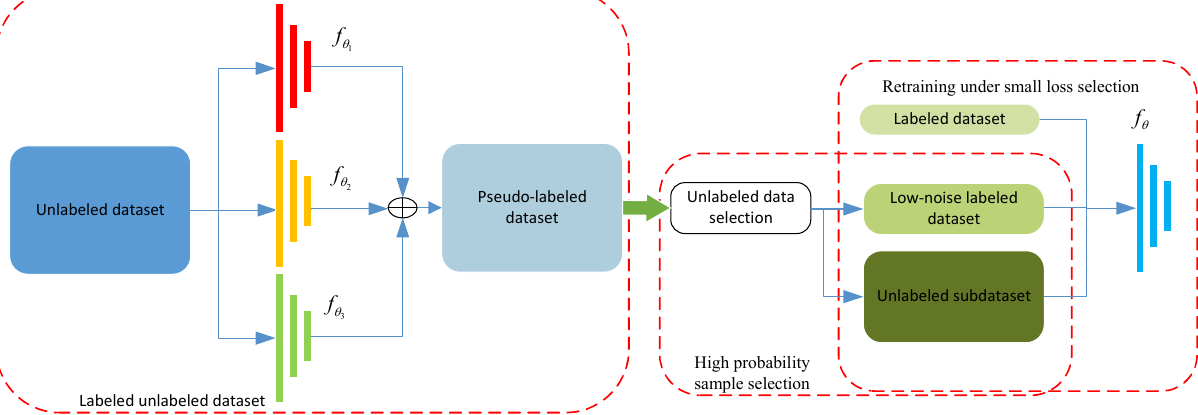
Figure 1. Framework of the proposed multi-screening unlabeled sample semi-supervised learning